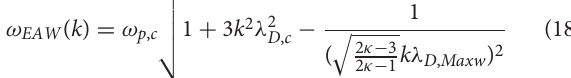
) with the analytical → +∞